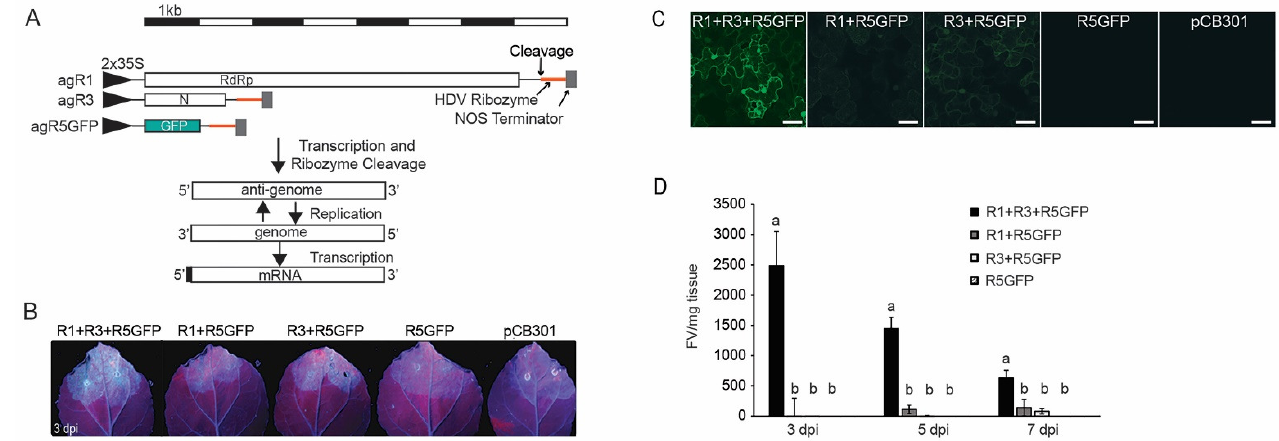
Figure 1. RRV-GFP replicon in N. benthamiana leaves. ( A ) The top is a scale bar divided into sectors representing 1 kb. Next is a diagrammatic representation of the pCB301-agR1, agR3, and -agR5GFP constructs. The black arrowheads represent the duplicated CaMV 35S promoters and the lines represent non-coding regions. Open boxes represent each ORF. The red bars identify the HDV ribozyme. The dark gray boxes represent the Nos terminator. The agR1 encodes the RdRp, agR3 encodes the N, and agR5GFP encodes GFP. Below the construct diagrams is a depiction of transcripts produced from the binary plasmids and subsequent replication of gRNAs and agRNAs. ( B ) Images of N. benthamiana leaves under a UV light at 3-dpi following agro-infiltration. Each panel label identifies the treatments. ( C ) Confocal microscopy image of N. benthamiana epidermal cells at 3-dpi. Scale bars = 20 µm. ( D ) Bar graph displaying the average FV/mg-tissue at 3, 5, and 7 dpi obtained from one representative experiment ( n =12). The letters above each standard error represent the statistical differences across treatments at each time point using Tukey’s HSD test with p < 0.1 Bars with the same letter are not significantly different for each time point.